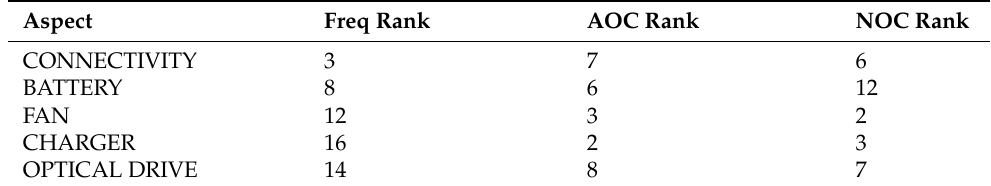
Table 6. Aspect class ranking summary. (Freq Rank = Frequency rank (Figure 7), AOC Rank =